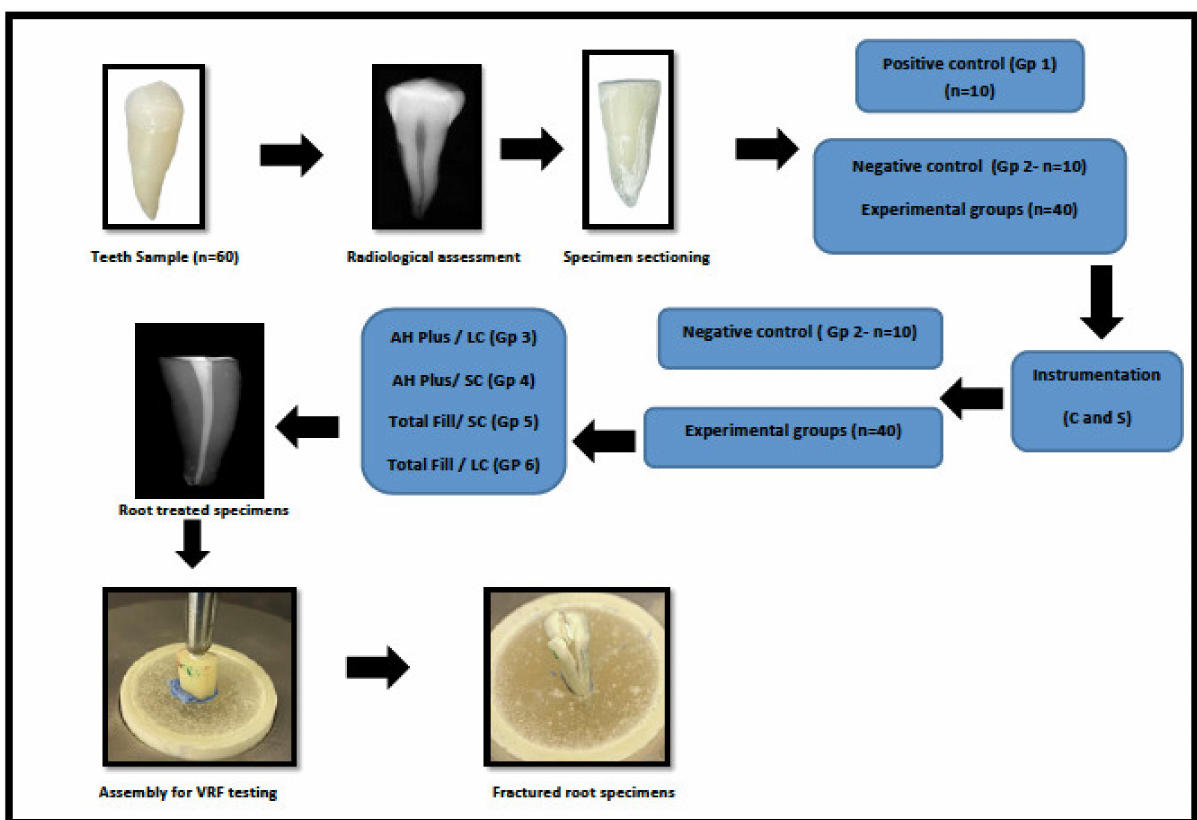
Figure 1. Flow chart for study